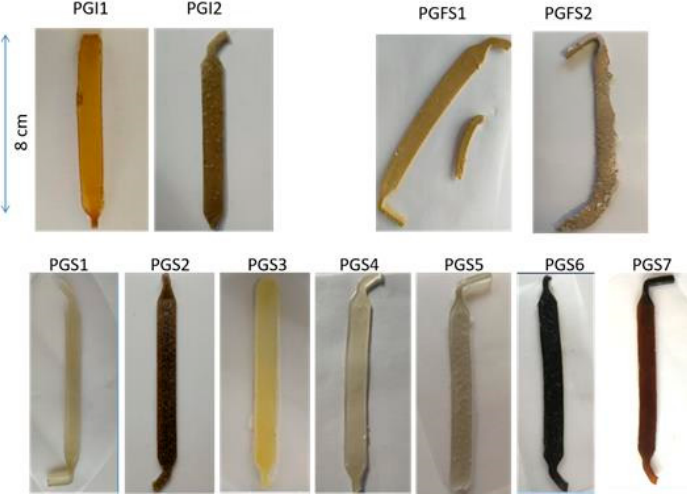
Figure 3. Photographs of elastomer sheets obtained by extrusion of their prepolymers when driven by the twin screws at a speed of 200 rpm and heated at 180 °C.